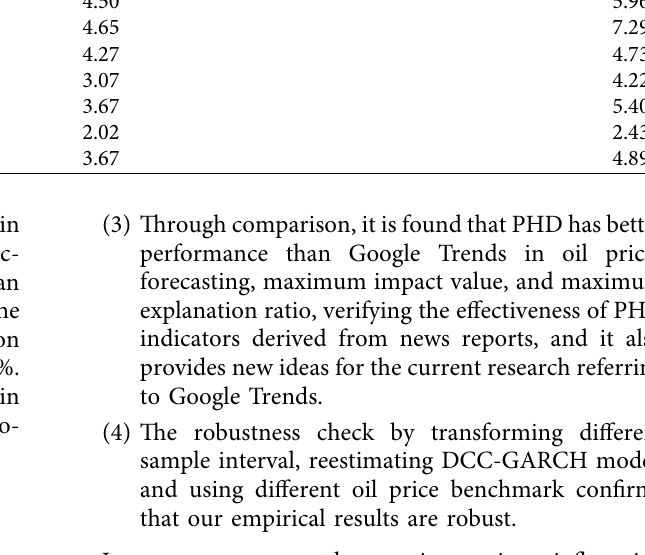
Table 10: The forecasting results of VAR